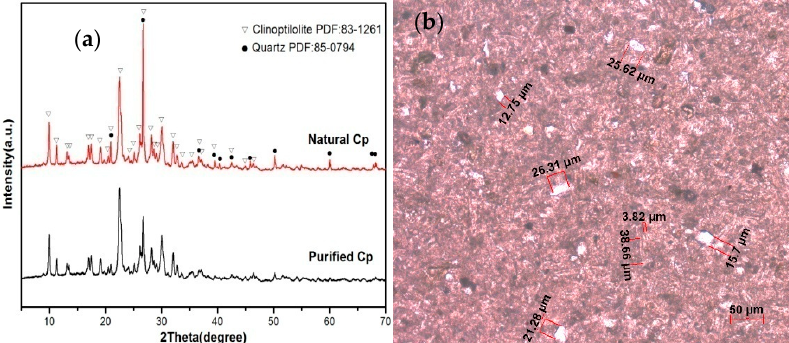
Figure 3. XRD patterns of natural Cp and purified Cp ( a ); the polarizing microscope with plane- polarized light showing the phase composition ( b ).